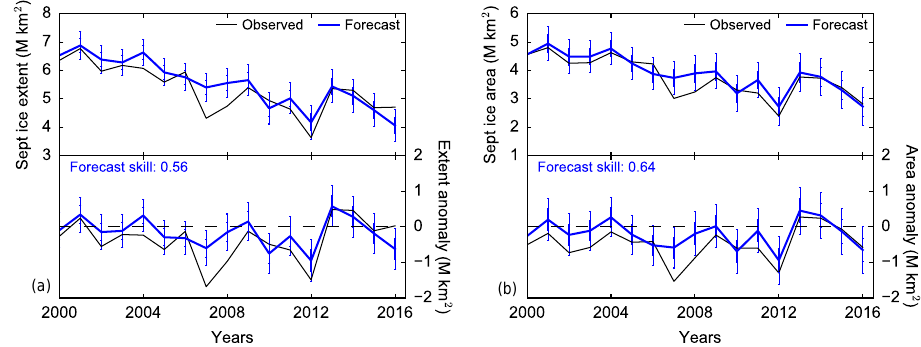
Figure 12. Forecasts of monthly sea ice extent (SIE, a ) and sea ice area (SIA, b ), generated using pan-Arctic NASA Team ice concentration data in June, following the spatial weighting forecast methodology described in Petty et al. (2017). The bottom panels show the anomalies relative to linear trend persistence. The skill value S = 1 − persistence anomaly (forecast anomaly), calculated from 2000 to 2016. Note that the vertical lines indicate a 1-standard-deviation confidence interval of the given